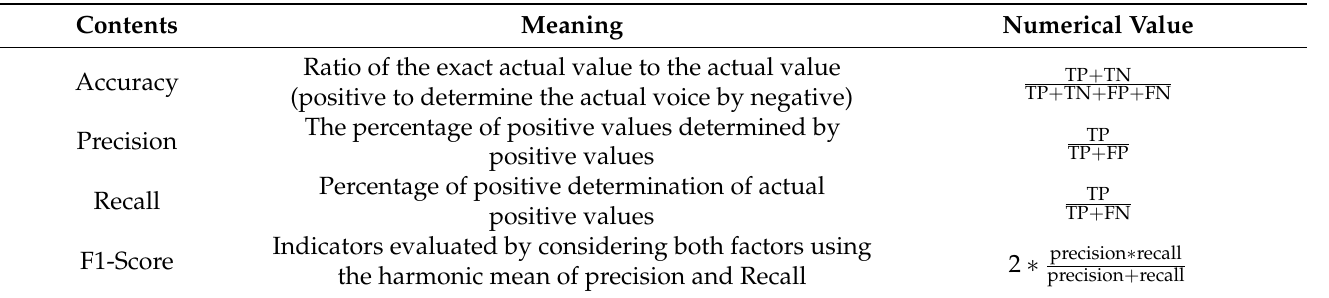
Table 2. Numerical values of confusion